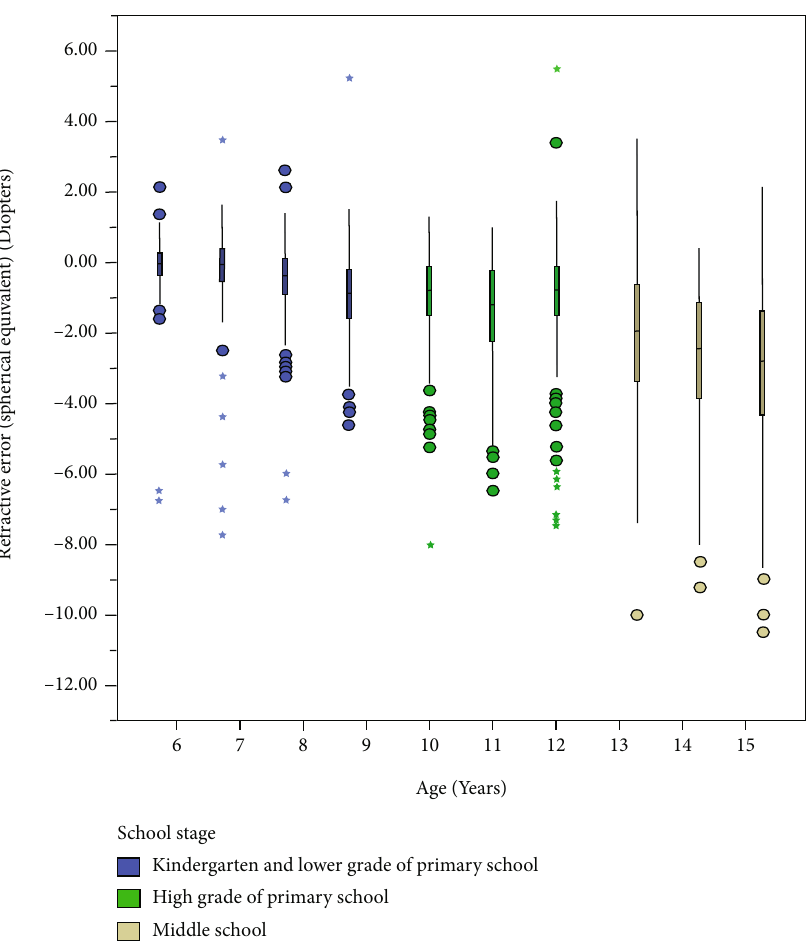
Figure 3: Distribution of the refractive errors (spherical equivalent) of the right eyes, strati fi ed by age and